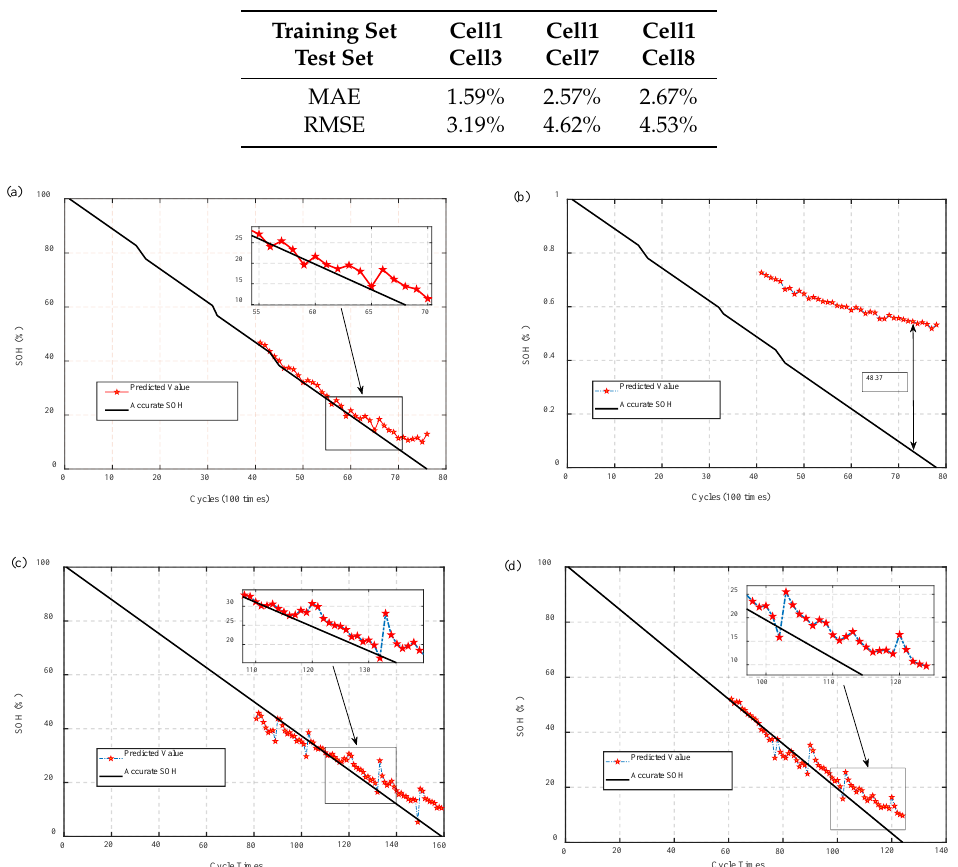
Figure 8. ( a ) All of Cell1 is used as the training set and rest half of Cell3 is used as testing data. ( b ) The former half of Cell1 is used as the training set and other half of Cell3 is used as testing data. ( c ) Integral data of Battery #05 are used as the training set and other half of Battery #07 is used as the testing set; the mean absolute error (MAE) is 2.13% and the mean squared error (MSE) is 3.80%. ( d ) Integral Battery #07 data is the training set and the other half of Battery #05 is used as the testing set; the MAE is 2.52% and the MSE is 4.12%. SOH—state of